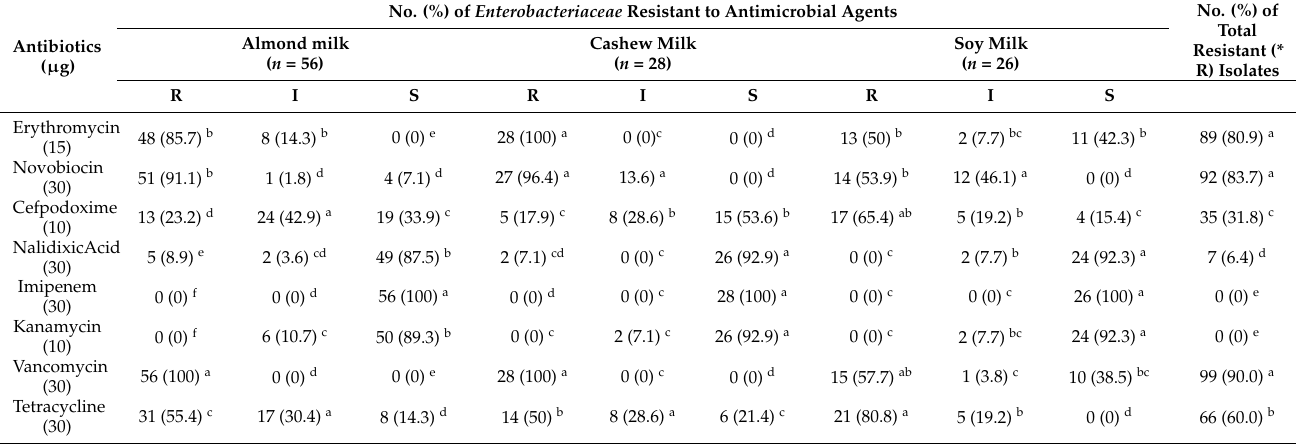
Table 2. Resistant Antibiotics Profile and Enterobacteriaceae Nut and Seed